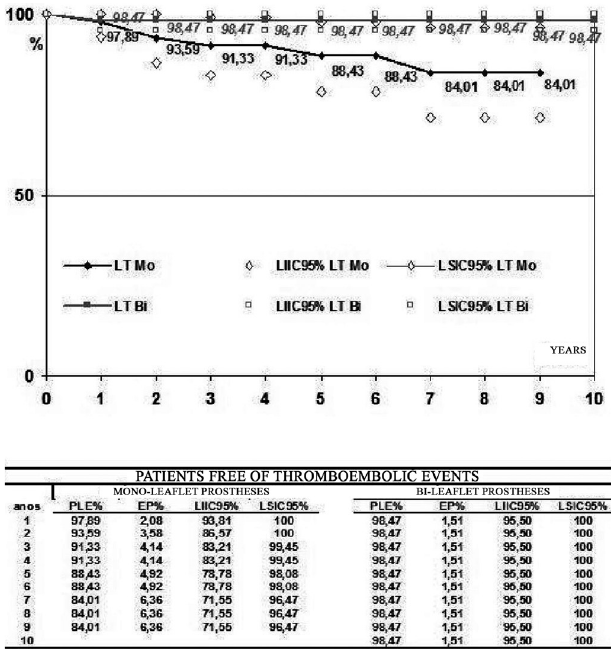
Fig. 2 - Curves and actuarial data showing the percentage of patients free of thromboembolic events FT (ordinate) with time - years (abscissa) for both types of prostheses studied. Mo = Mono-leaflet prosthesis; Bi = Bi-leaflet prosthesis; SE = standard error range; LLCI95% = lower limit of 95% Confidence Interval and ULCI95 % = Upper Limit of 95% Confidence